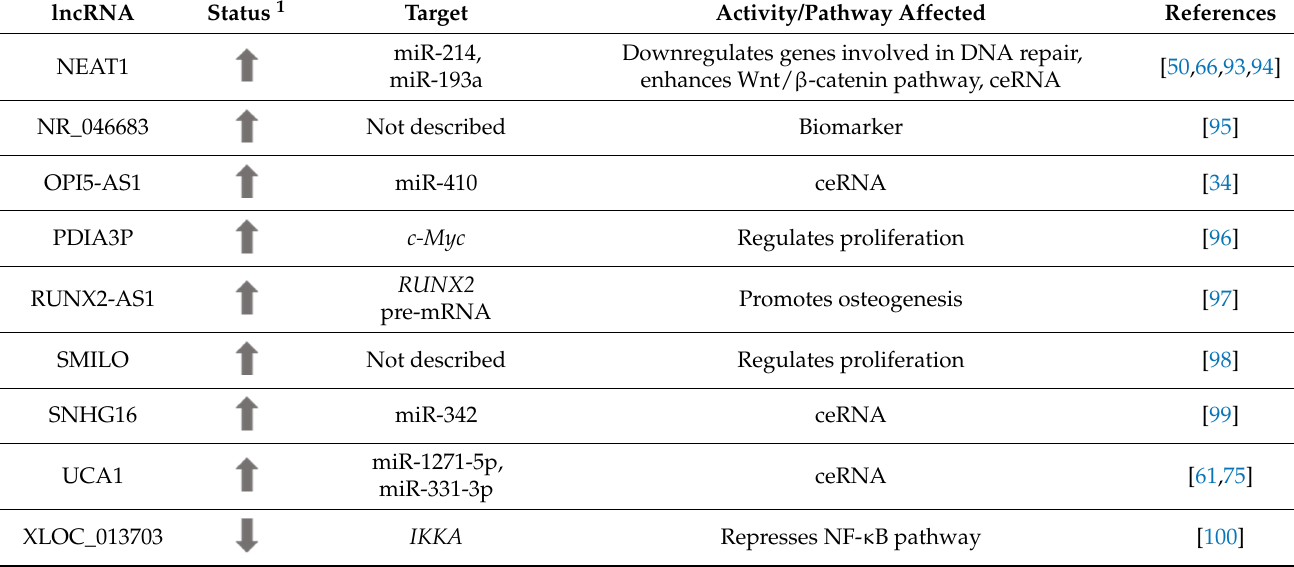
Figure 2. lncRNA classification attending to their localization. The enhancer, intronic, and intergenic lncRNAs contain their own promoters that are distinct from protein coding gene. Bidirectional lncRNAs share promoter with a protein coding gene and are transcribed from the opposite strand of the gene. Antisense (AS) lncRNAs have been involved in the transcriptional interference of the neighboring protein coding genes.